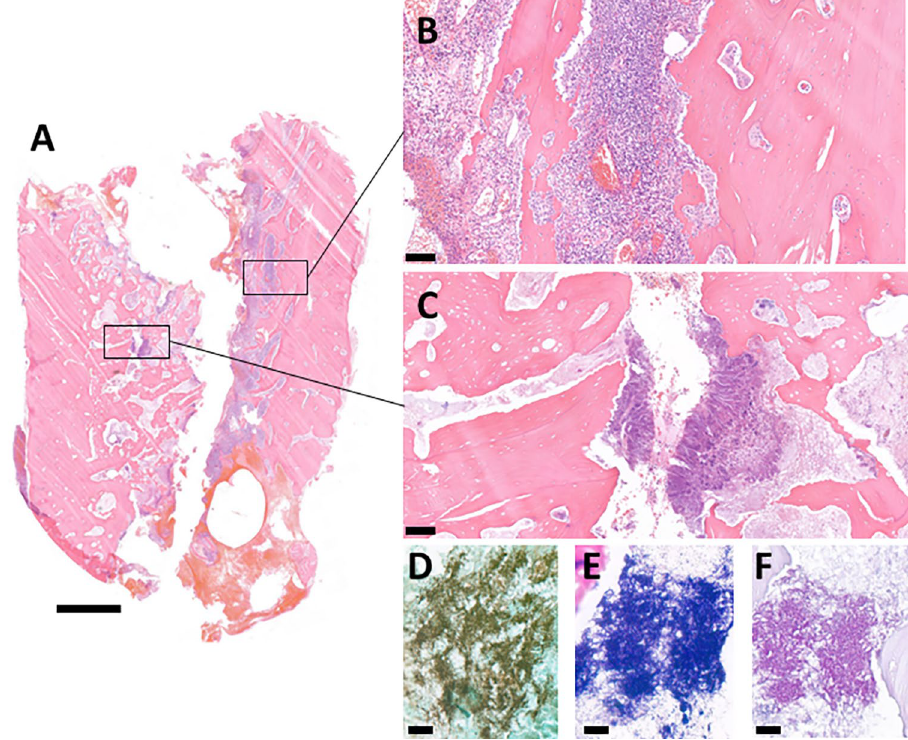
Figure 2. ( A ) Full cross section of a mandible resection specimen containing both ( B ) viable bone only with signs of inflammation and ( C ) necrotic bone containing Actinomyces colonies. ( D ) GMS- ( E ) Gram- and ( F )